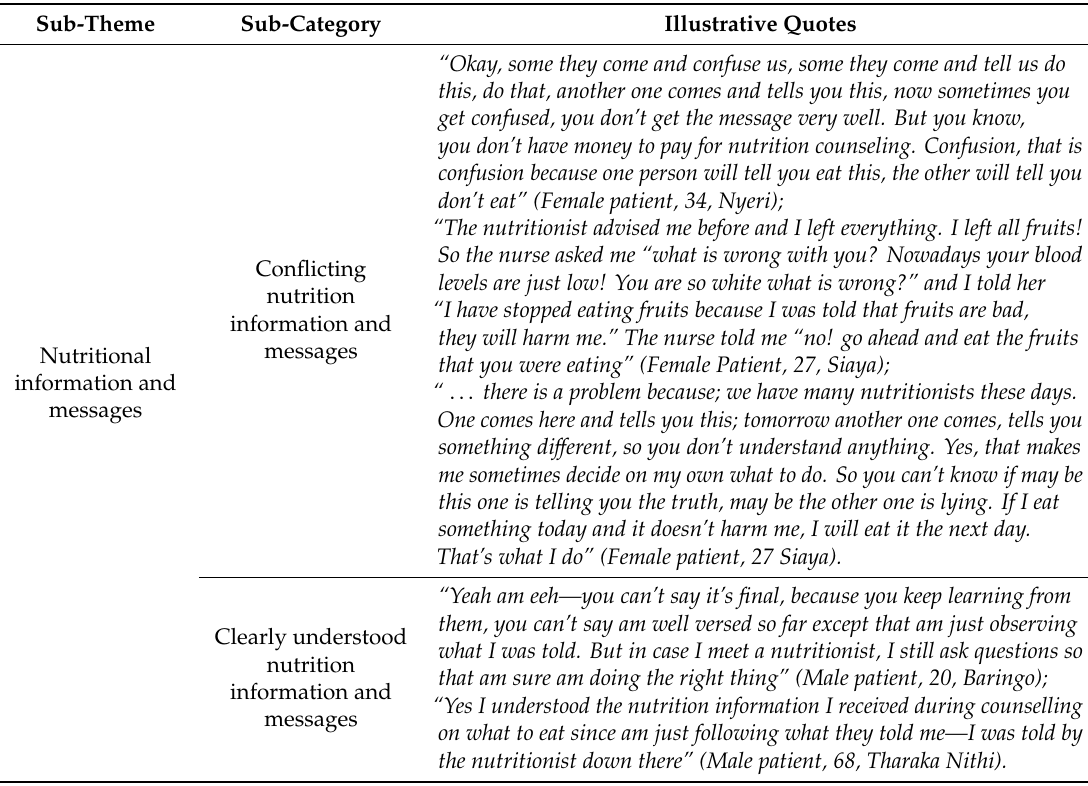
Table 4. Sub-theme 4—illustrative quotes on “nutritional